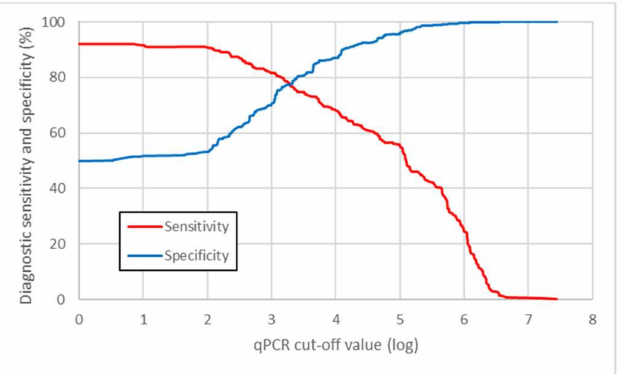
Figure 6. Diagnostic sensitivity and specificity of qPCR for mycobacteria detection. Figure interpreta- tion. CFU = colony - forming unit. Table 5. Diagnostic sensitivity and specificity at optimal cut-off value derived for the predictive model.